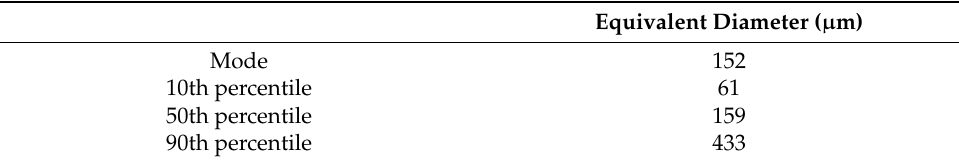
Figure 1. Distribution of particle size of the metal debris after implantoplasty. Table 2. Granulometry results of the Ti6Al4V powder.